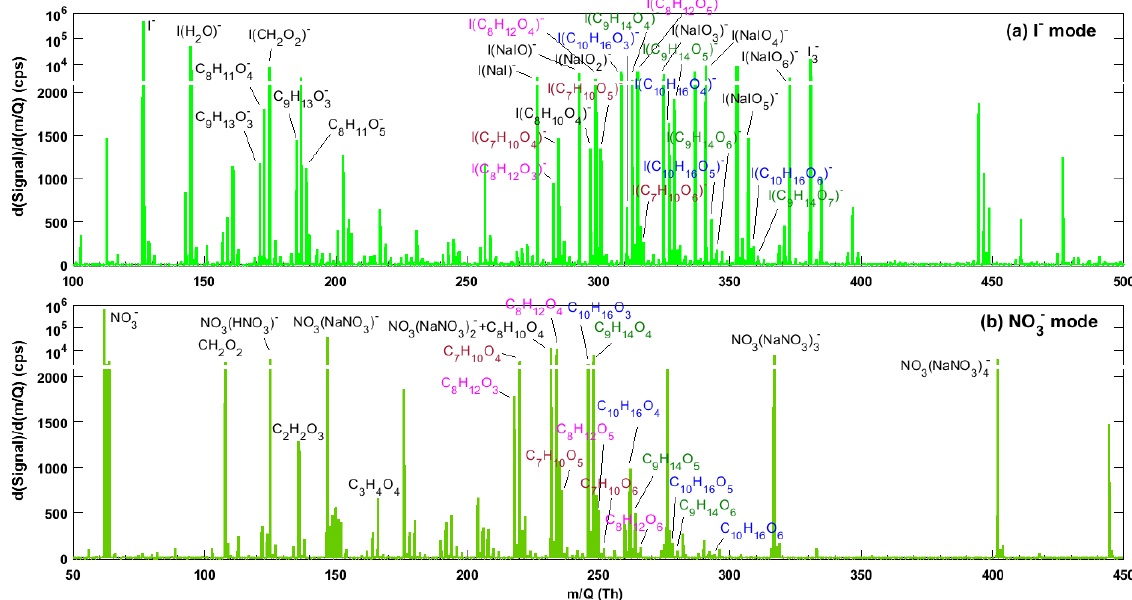
Figure 8. High-resolution mass spectra obtained during ozonolysis of α -pinene in a steady-state chamber in (a) I − and (b) NO − NO − mode, the chemical formulae of organic ion clusters are shown without the corresponding NO − 3 organic ions without a NO − adduct were negligible components of the spectrum. 3